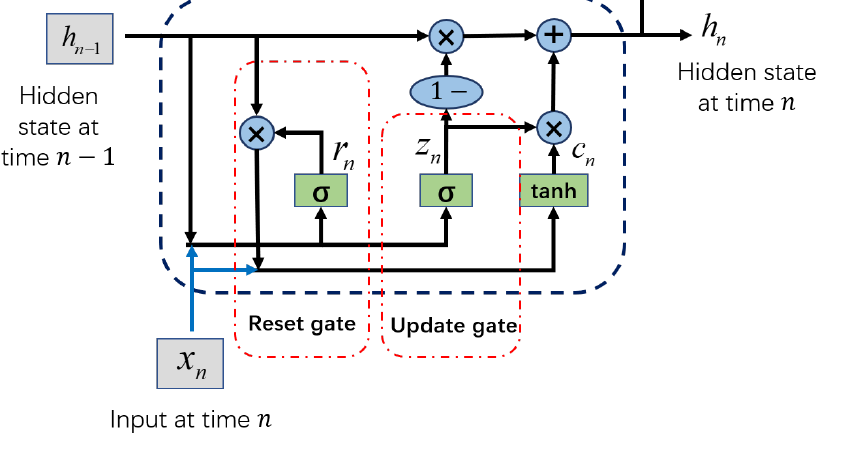
Figure 7. The GRU model